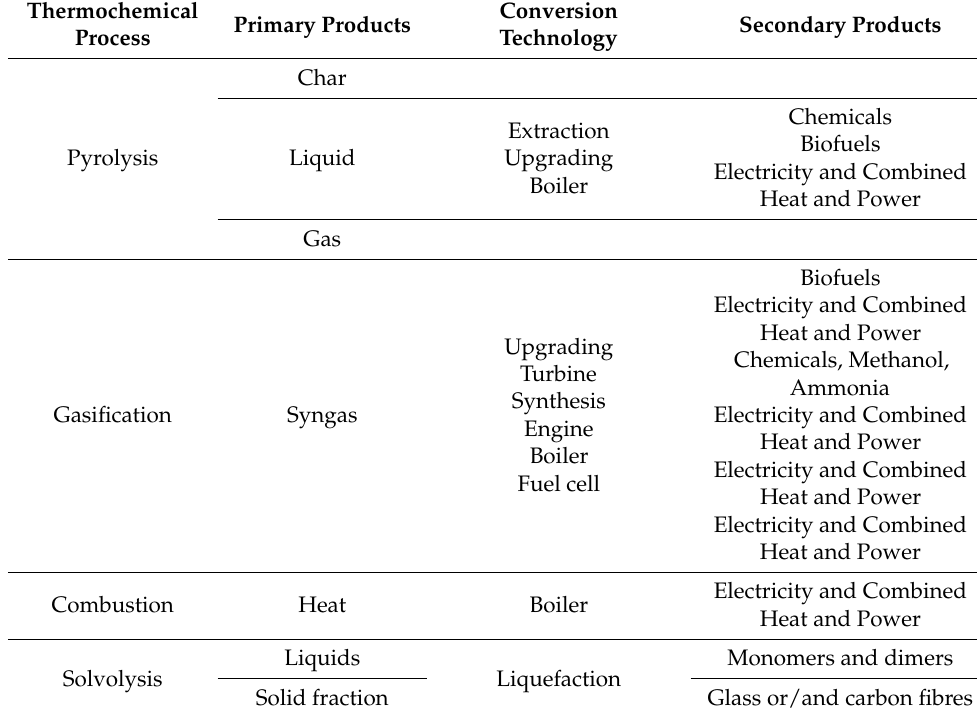
Table 1. Thermal and chemical processing and products in the plastic waste utilisation (ITPE (Institute of Energy and Fuel Processing Technology) and SUT (Silesian University of Technology),